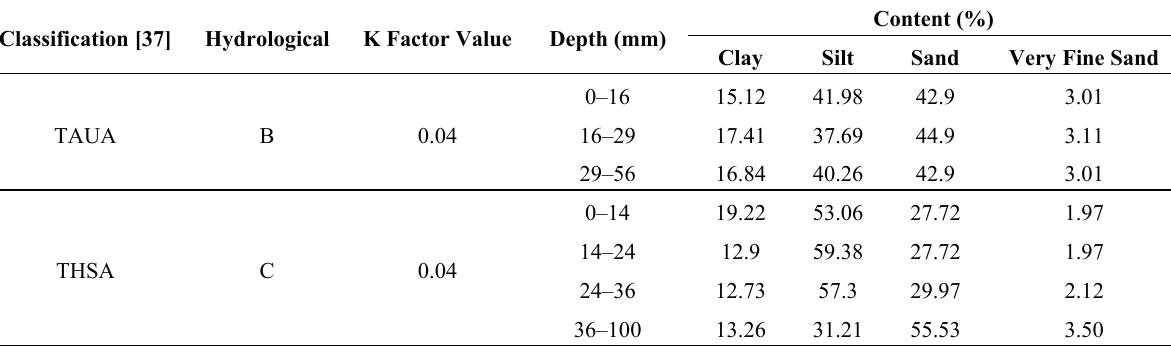
Figure 1. The Map of the Wucun watershed showing sampling sites, the digitized stream and the watershed boundary. Table 1. Properties of soils in the study